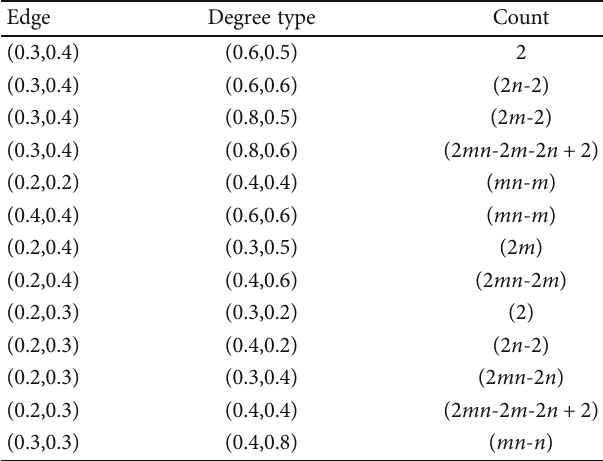
Table 4: Edge type according to the degrees for general fuzzy graph.